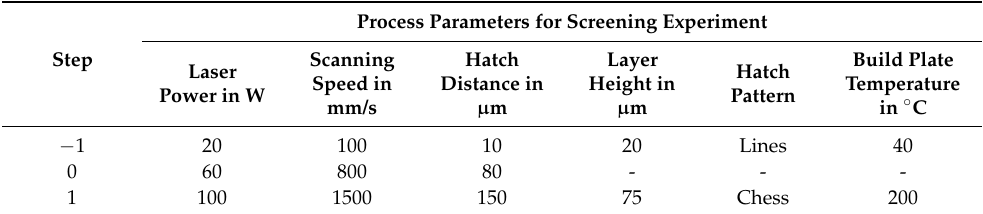
Table 1. Parameters for the central composite design of the first parameter